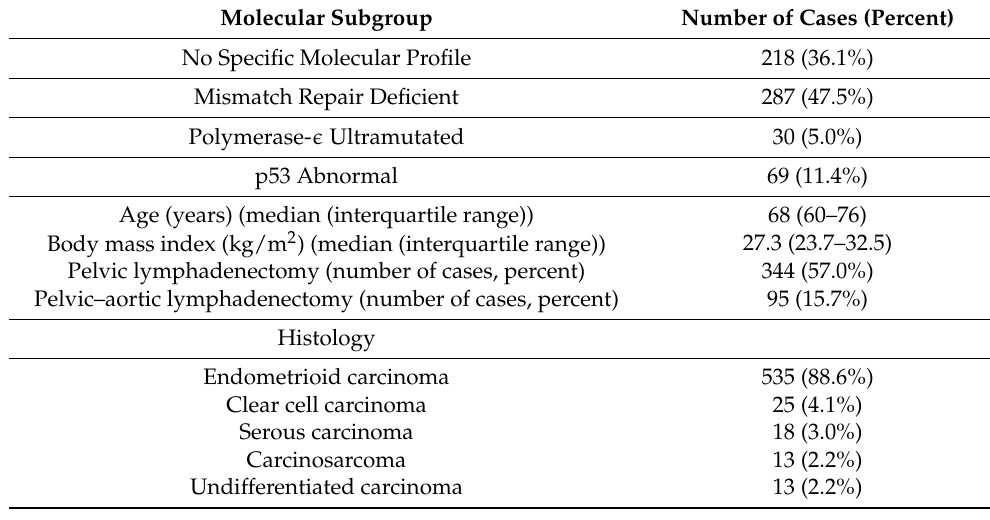
Table 1. Clinicopathologic data (n =